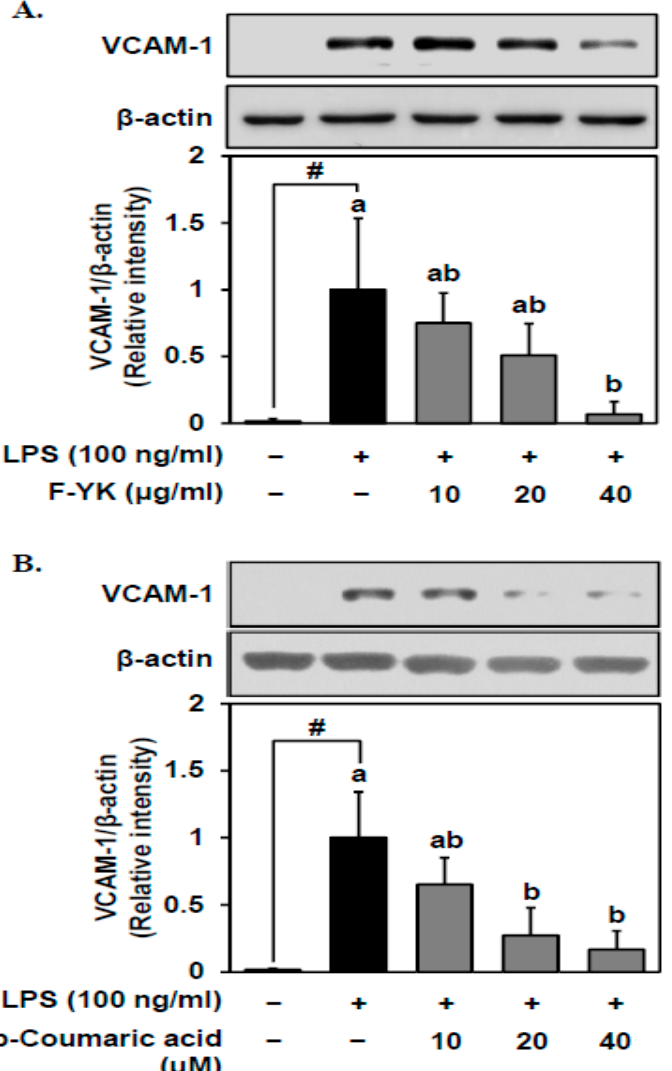
Figure 4. Effect of fermented YK extract and its bioactive compound p-coumaric acid on vascular cell adhesion molecule (VCAM)-1 expression levels in LPS-stimulated endothelial cells. After pretreatment with ( A ) fermented YK extract and ( B ) p-coumaric acid of various concentrations for 1 h, HUVECs were stimulated with LPS for 5 h. VCAM-1 protein expression was measured by Western blot analysis as described in the Materials and Methods. Data are expressed as mean ± SD ( n = 3). Student’s t -test was used for statistical analysis between control and LPS treatment; # ( p < 0.05). Data were analyzed using one-way analysis of variance (ANOVA) followed by Tukey’s honest significant difference test. Different letters (a and b) on the top of the bars indicate significant differences ( p < 0.05) among different sample treatments with LPS. F-YK, Yak-Kong extract fermented with P. pentosaceus AOA2017; +, treated with LPS or samples, − , not treated with LPS or samples.